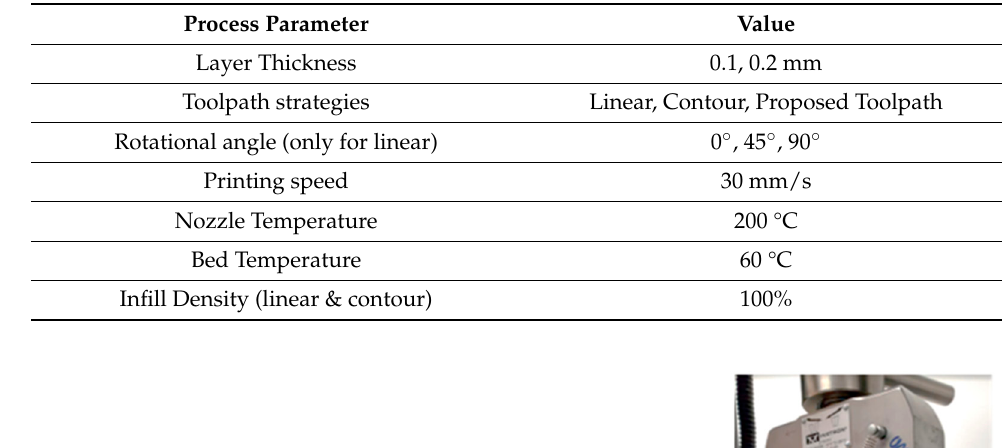
Table 2. Process Parameters that are used in experiments.